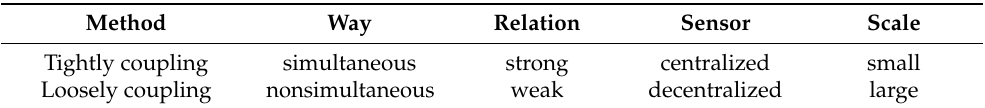
Table 1. Comparison of coupling